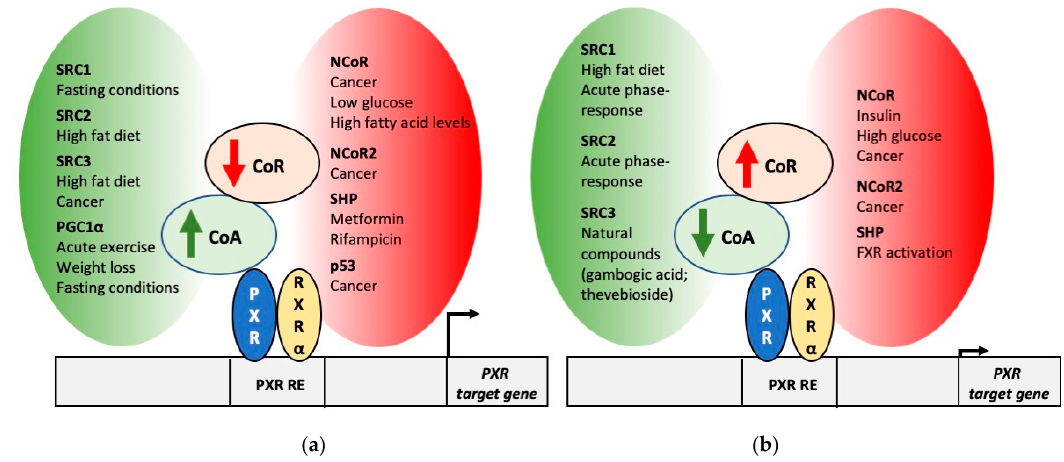
Figure 1. Modulation of the expression of coregulators and its impact on PXR activity. ( a ) Physiological and pathophysi- ological factors leading to an increase in coactivator expression and a decrease in corepressor expression. These factors may result in an increase in PXR transcriptional activity. ( b ) Physiological and pathophysiological factors leading to a decrease in coactivator expression and an increase in corepressor expression. These factors may result in a decrease in PXR transcriptional activity. Abbreviations: CoA: coactivator; CoR: corepressor; FXR: farnesoid X receptor; NCoR: nuclear receptor corepressor; PGC1 α : peroxisome proliferator-activated receptor γ (PPAR γ ) coactivator 1 α ; PXR: pregnane X receptor; PXR RE: PXR response element; RXR α : retinoid X receptor α ; SHP: small heterodimer partner; SRC: steroid receptor